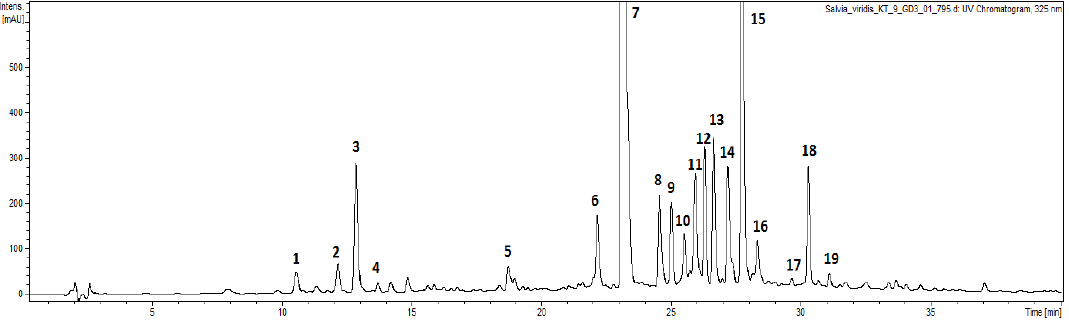
Figure 1. UPLC-UV chromatogram of hydroethanolic extract from aerial parts of S. viridis. Peak numbers refer to those used in Table 1. Table 1. UPLC-DAD-ESI-MS n data of detected and identified polyphenolic compounds in extracts of aerial parts of S. viridis.